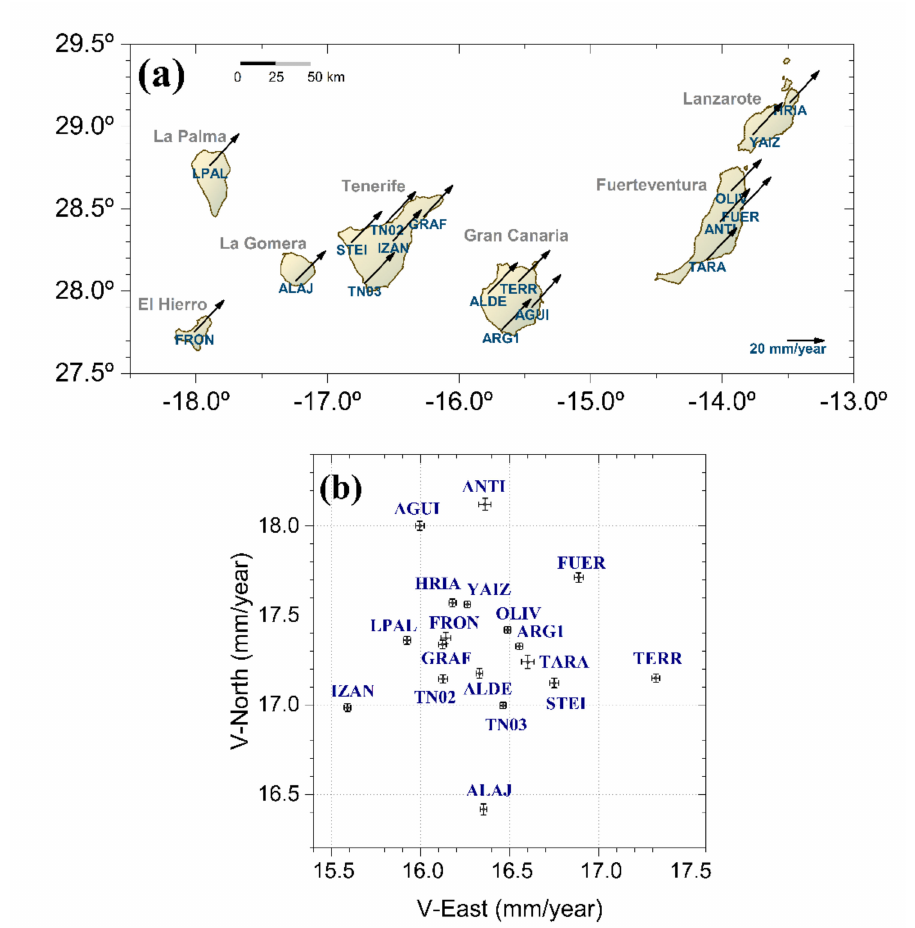
Figure 2. ( a ) Global Navigation Satellite System (GNSS) station velocities for April 2011 to December 2017 with respect to the ITRF2014 frame. ( b ) Velocity space calculated after the common-mode component (CMC) analysis. The error bars centred at each station indicate one-sigma